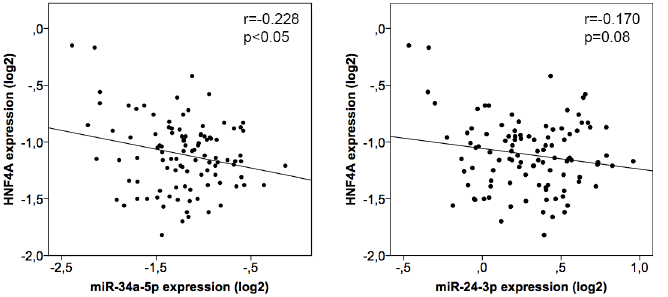
Fig 5. Linear regression analysis between endogenous mature miRNAs (miR-24and miR-34a) levels and HNF4A mRNA.qRT-PCR were performed in total RNA purified from healthy livers (n = 104). Statistical significance was taken as p < 0.05. The results are presented as Log2 fold change with respect to the normalization